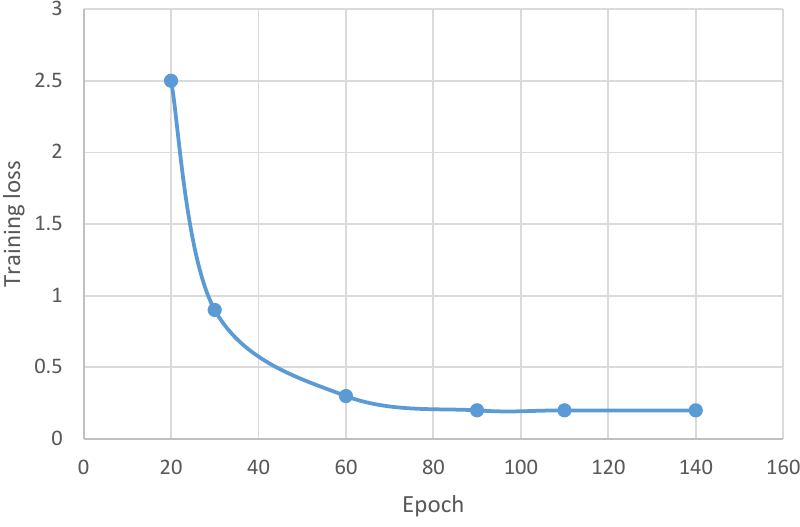
Figure 11. Training loss of the proposed model.